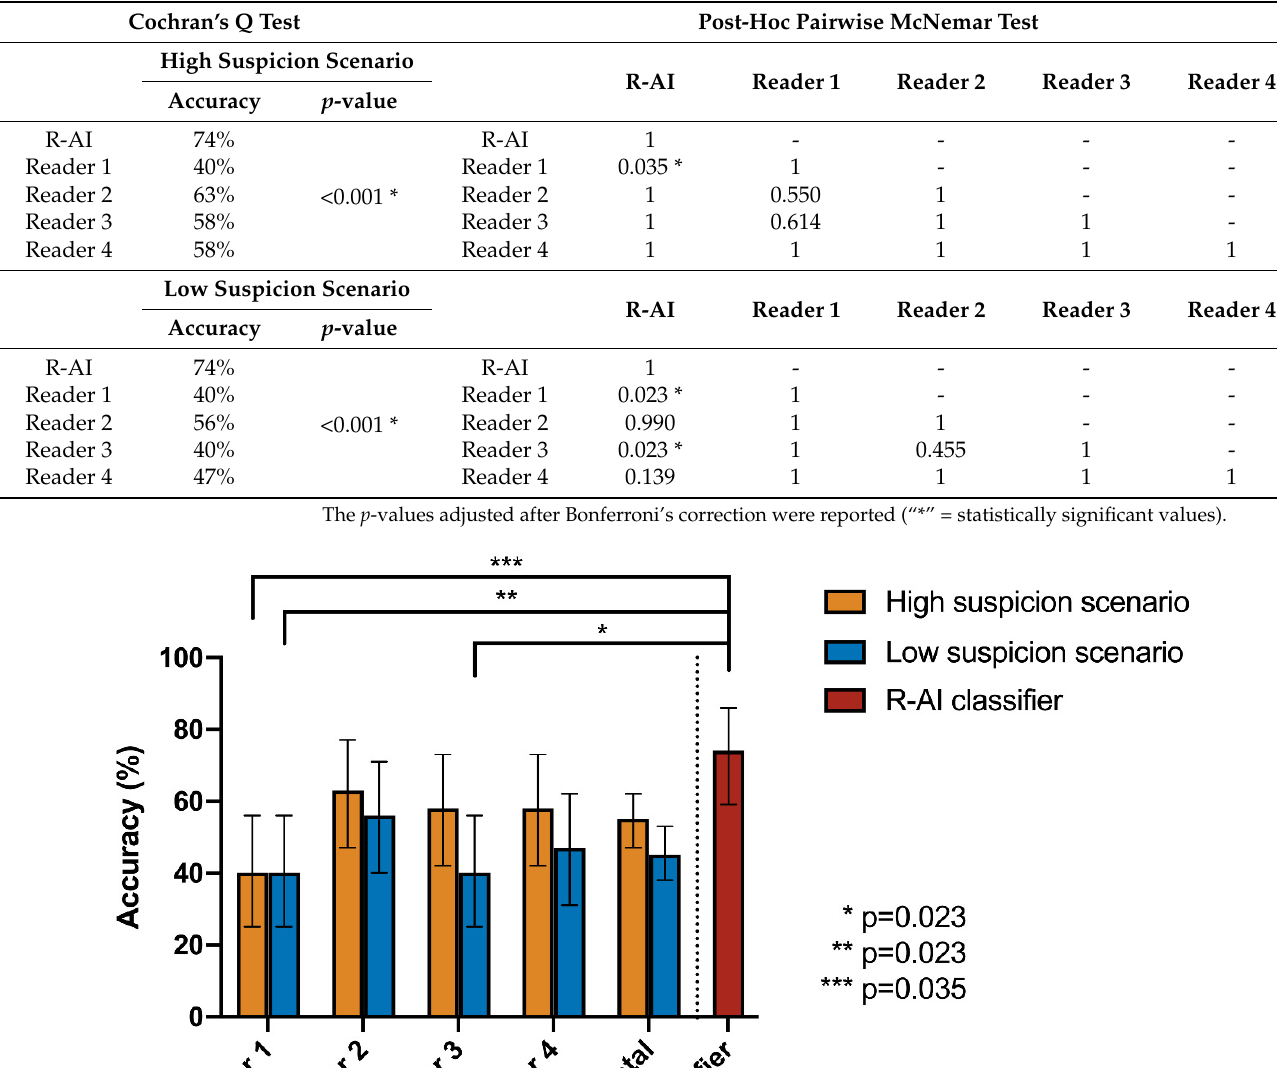
Table 6. Comparative analysis of diagnostic performance of radiomic-based artificial intelligence classifier (R-AI) and human readers in classifying the subset ( n = 43) of patients who were assigned a CO-RADS 3 score by two or more readers.